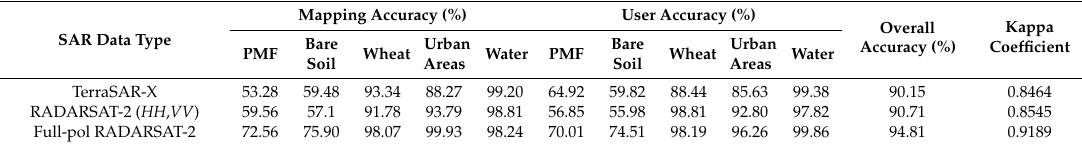
Table 4. The accuracies of the classification of the five land cover types using different SAR